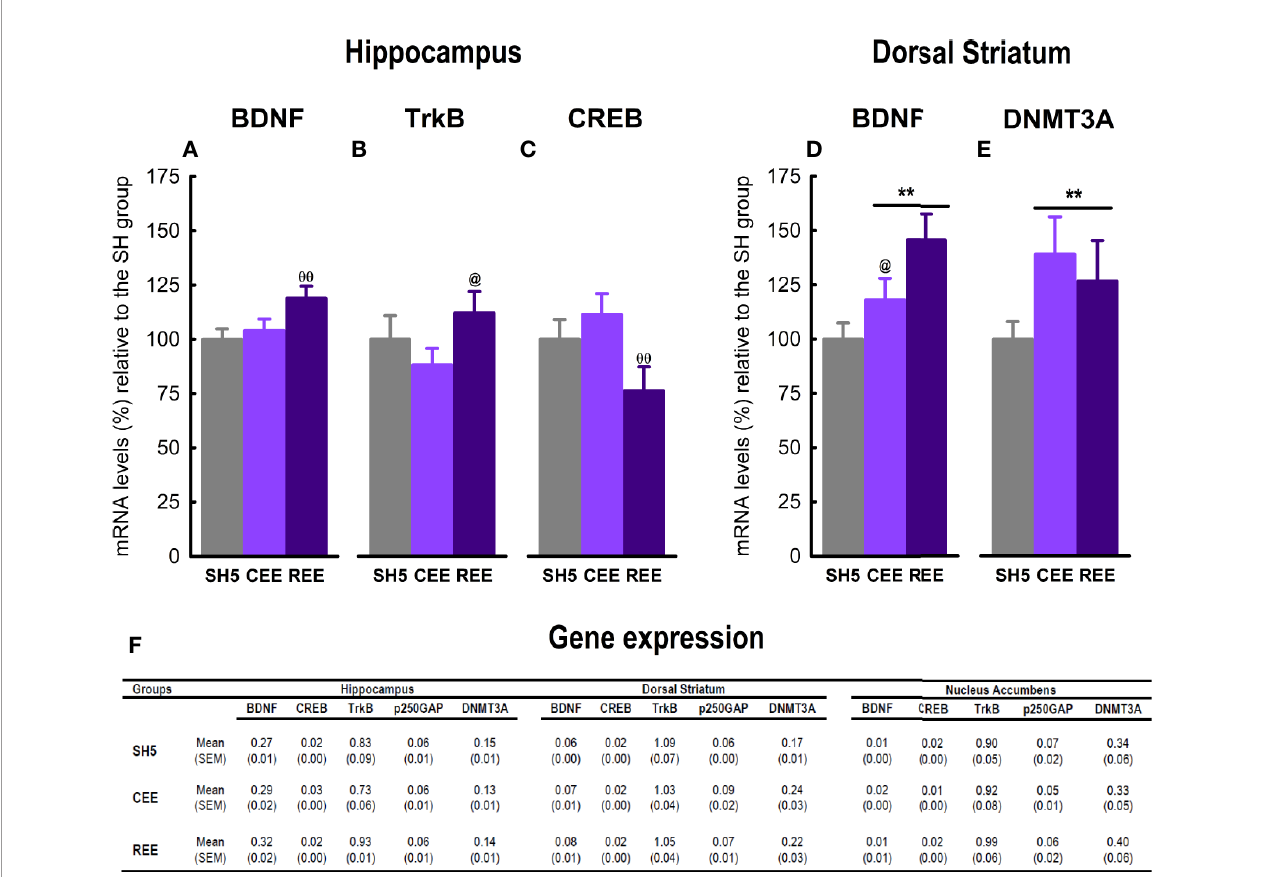
FIGURE 8 | Effects of environmental enrichment on gene expression. Relative mRNA expression of BDNF (A) , TrkB (B) and CREB (C) in the hippocampus, and BDNF (D) and DNMT3A (E) in the dorsal striatum. The mRNA expression levels in all the brain regions analyzed (F) . Data correspond to percentages relative to the mean of the SH5 group (A – E) or 2 − dCT values (F) expressed as mean ± SEM. SH5, standard housing with fi ve rats. CEE, continuous environmental enrichment; REE, restricted and unpredictable environmental enrichment. Symbols correspond to single, planned comparisons between groups. REE vs. CEE and SH5: QQ p < .01. REE vs. CEE: @ p < .05. CEE and REE vs. SH5: ** p <